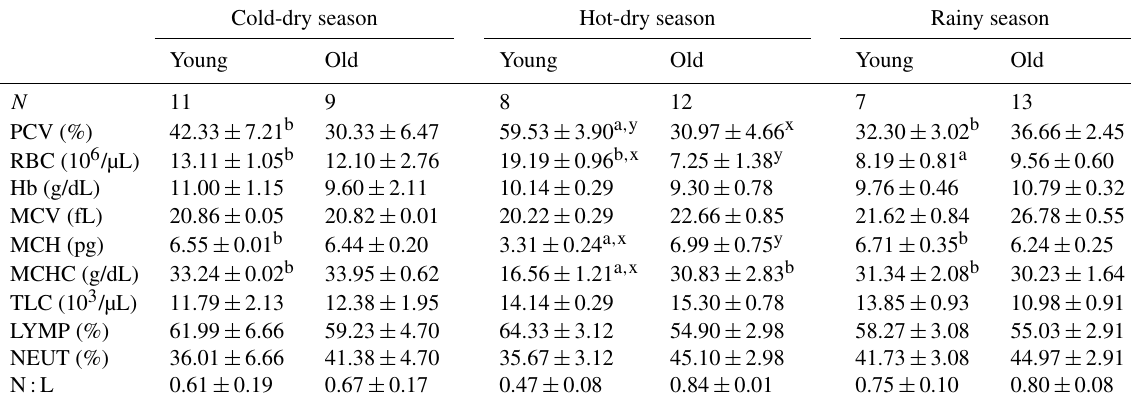
Table 6. Effect of season on haematological parameters of younger (1–2 months) and older (3–4 months) Sahel goat kids. Cold-dry season